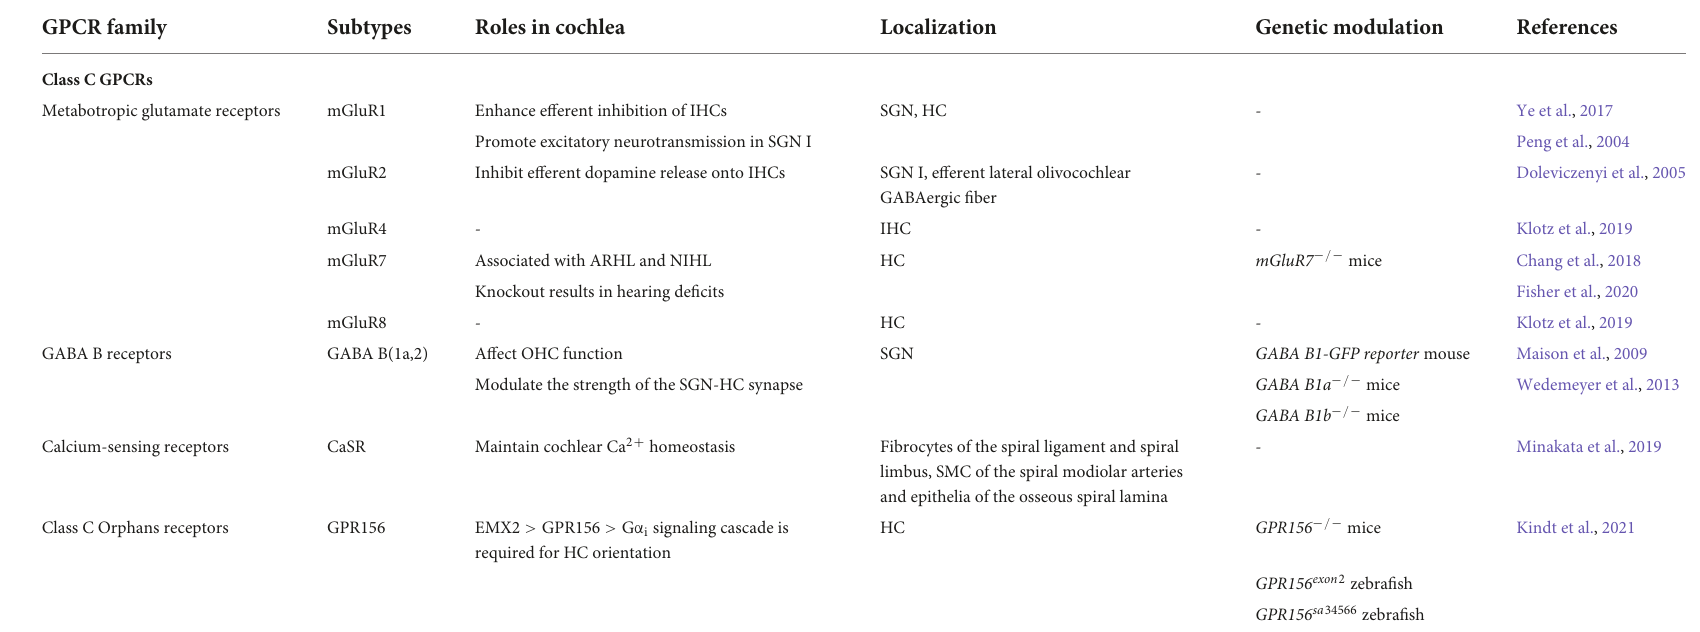
TABLE 4 Class C GPCRs relevant to